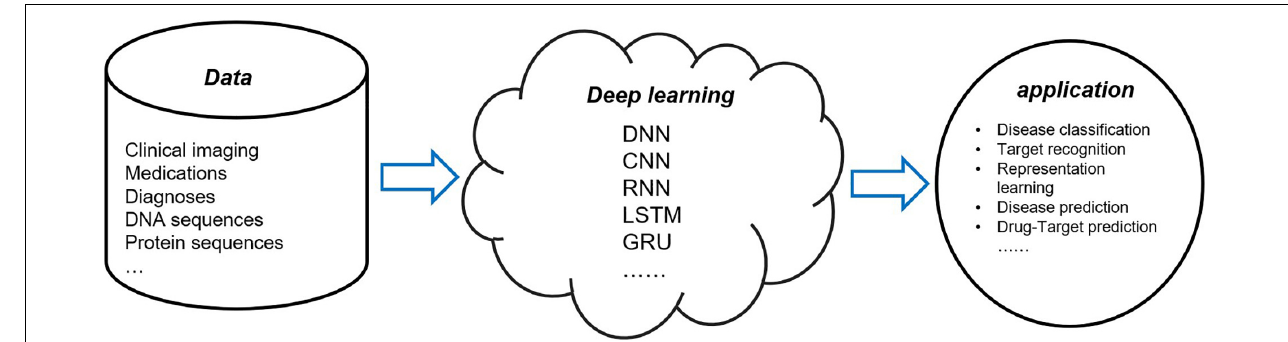
FIGURE 1 | Application of deep learning models in computational